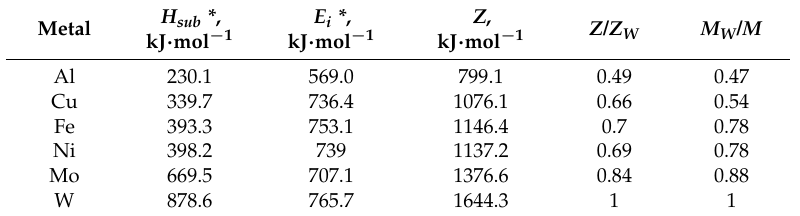
Table 4. Comparison of the erosion stability Z with the electroerosion machinability M for different